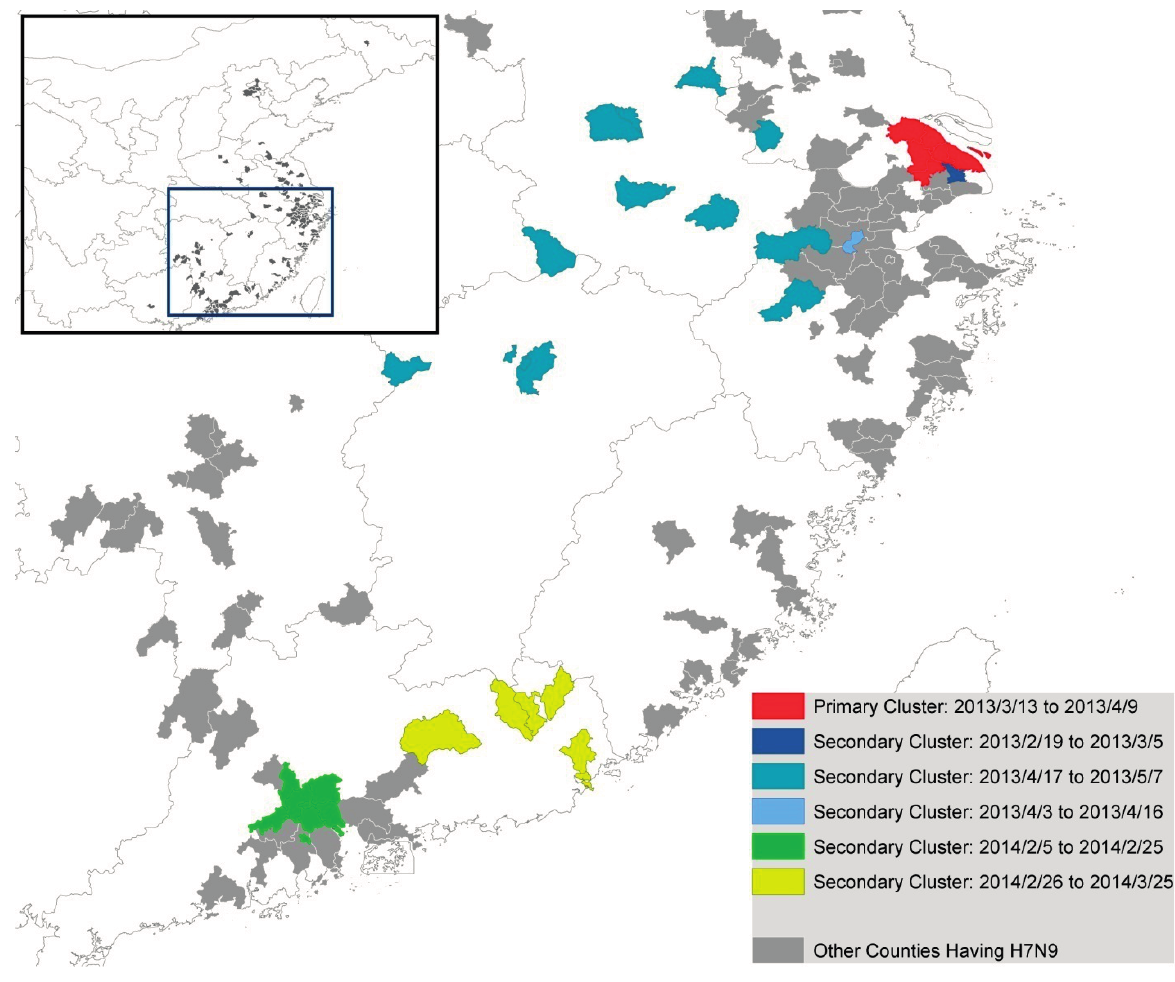
Figure 5. Temporal-spatial clustering of human H7N9 cases detected by